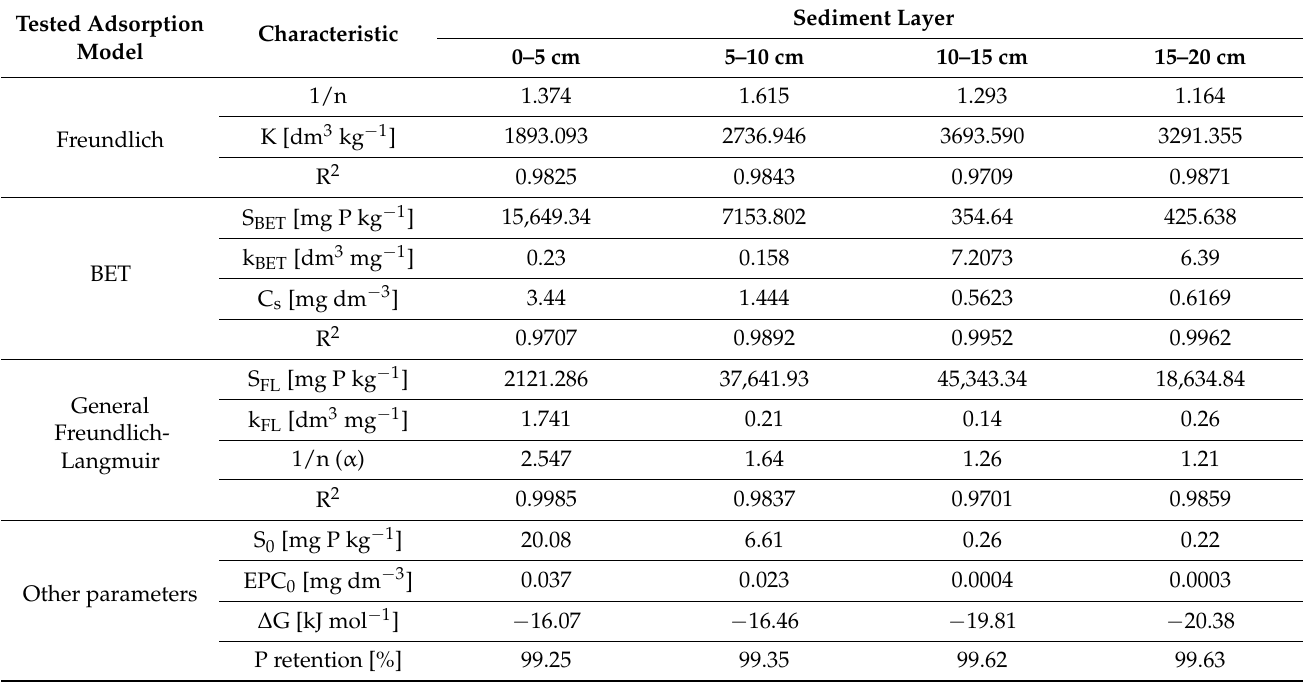
Table 4. P adsorption characteristics of bottom sediment of Lake Kortowskie at St. 2 (experimental).